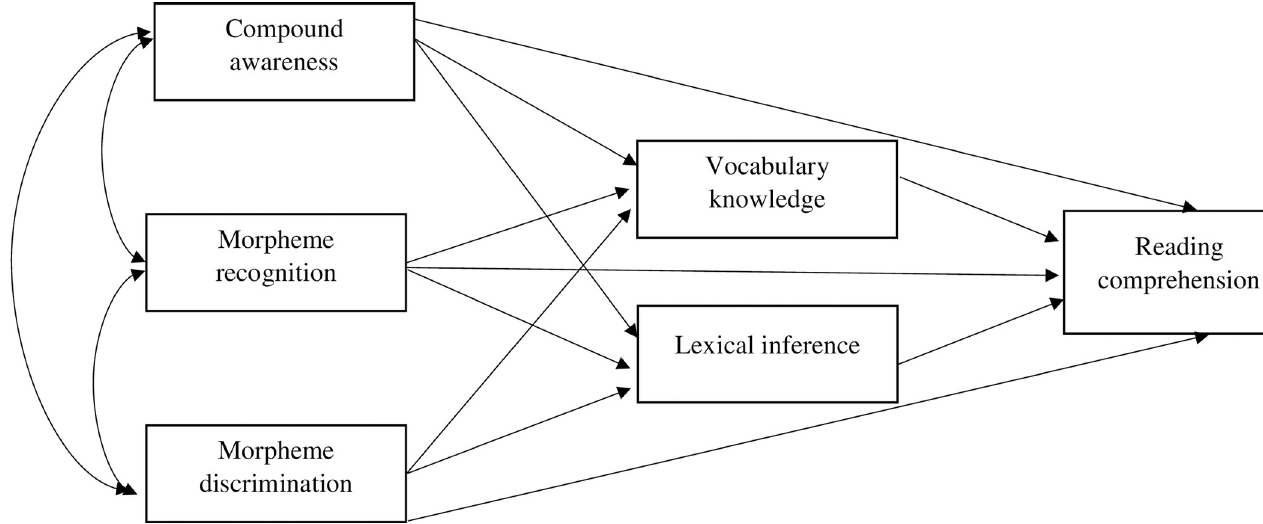
Fig 1. Model 1 showing multidimensionality of morphological awareness separate from vocabulary knowledge in predicting reading comprehension via the mediation of both vocabulary knowledge and lexical inference.